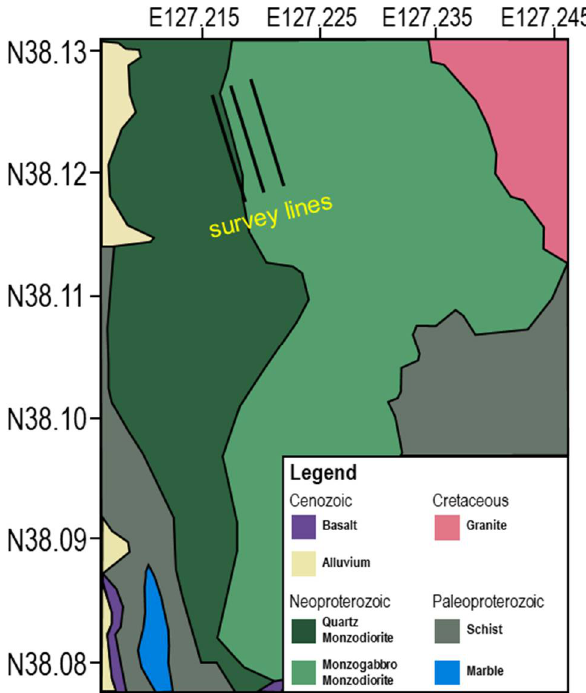
Figure 2. Geologic map of the Yeoncheon titanomagnetite deposit (modified from Kee et al.